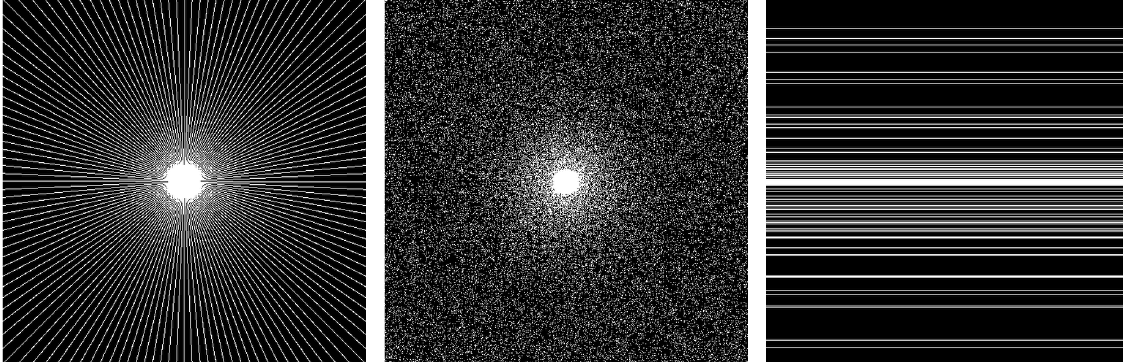
Figure 4. The different undersampled masks with a sampling rate of 15%. From left to right: radial mask, variable density mask, and Cartesian